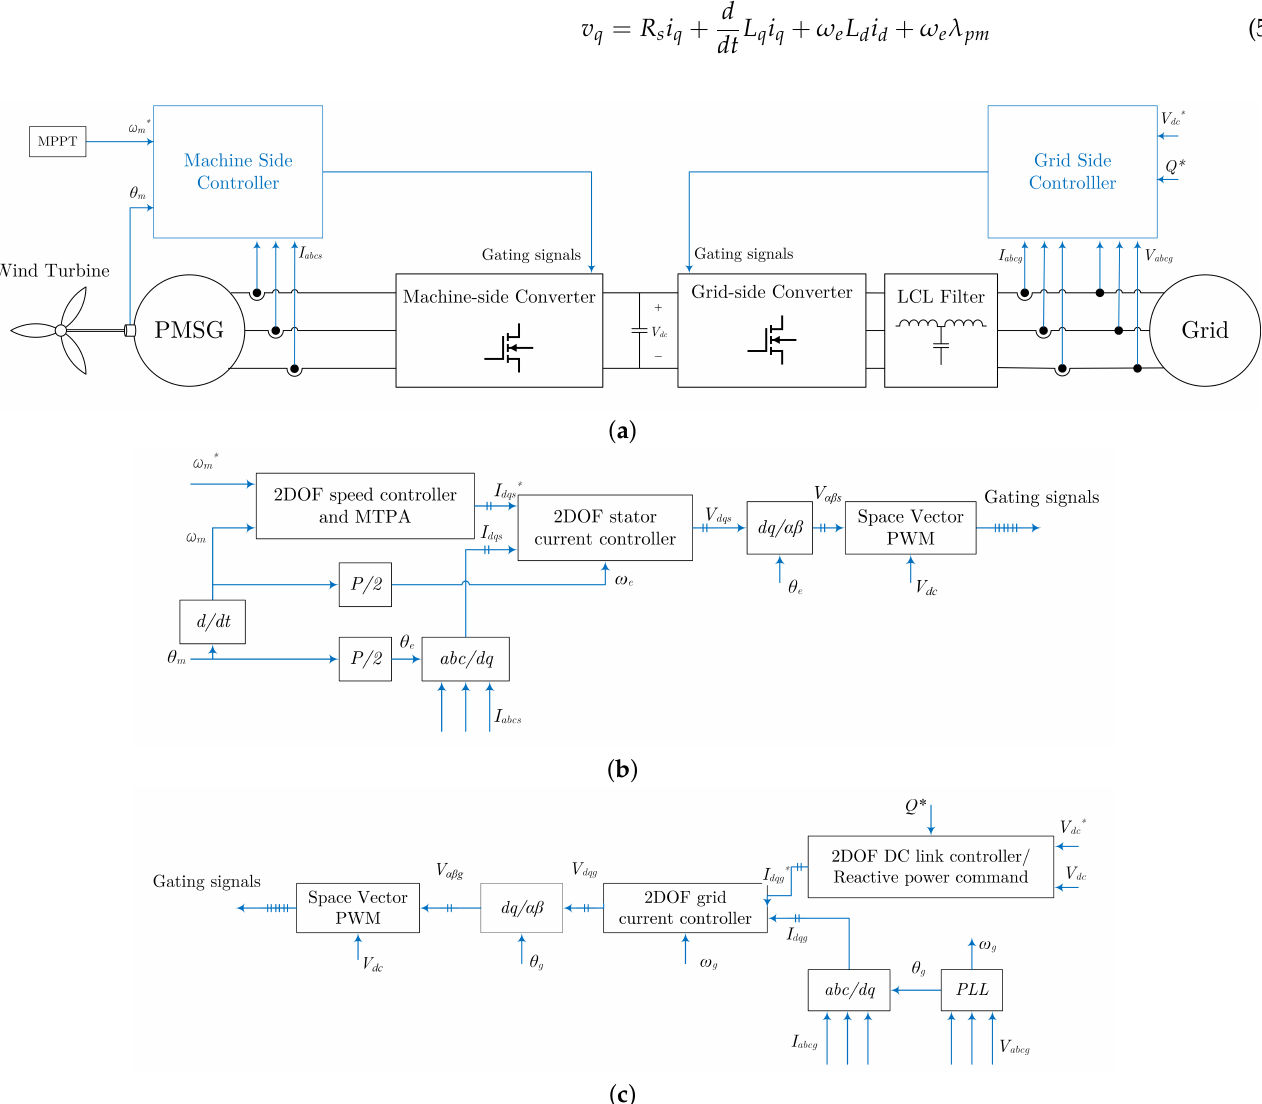
Figure 1. Block diagram of the wind turbine converter: ( a ) The overall system, ( b ) The control of the machine-side converter, and ( c ) The control of the grid-side